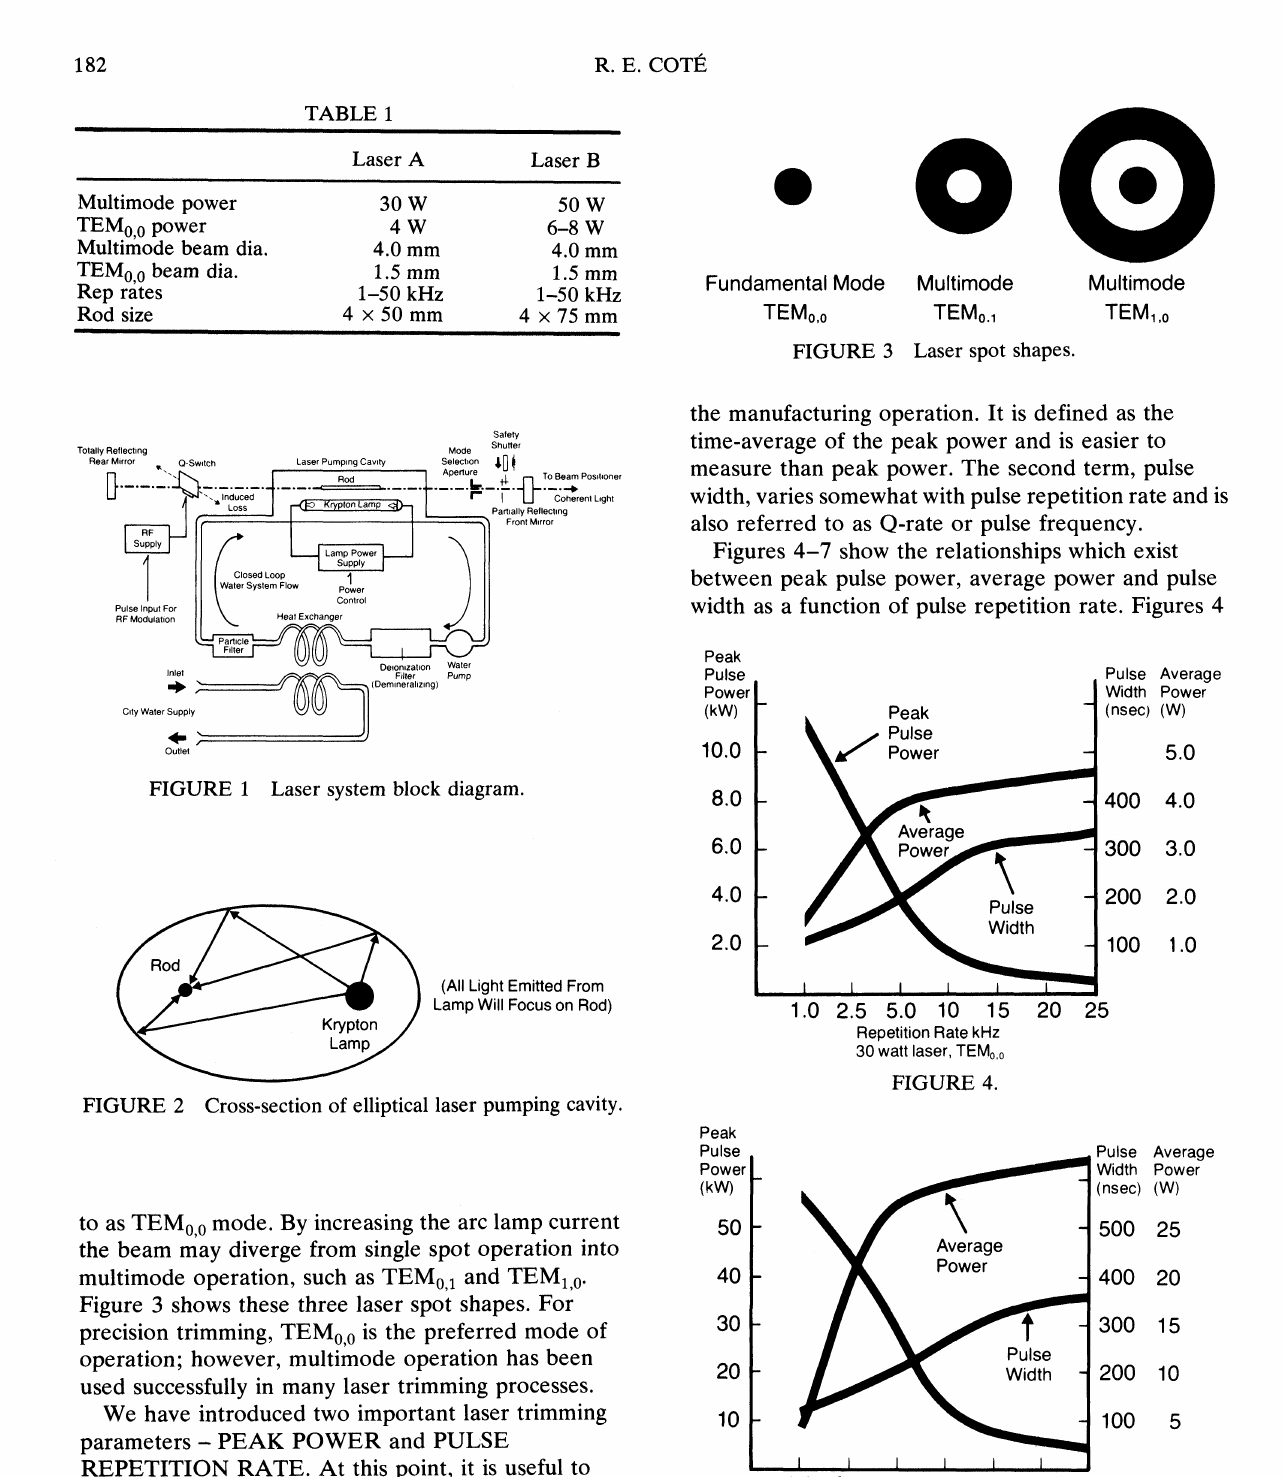
FIGURE 2 Cross-section of elliptical laser pumping